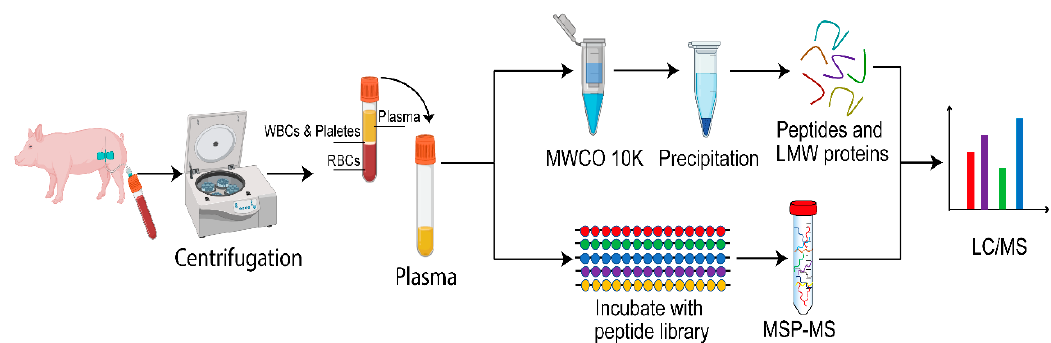
Figure 1. Overview of the protocols applied for the analysis of peptidase activity in pig plasma using multiplex substrate profiling by mass spectrometry assay (MSP-MS) and shotgun label-free quantitative peptidomics.